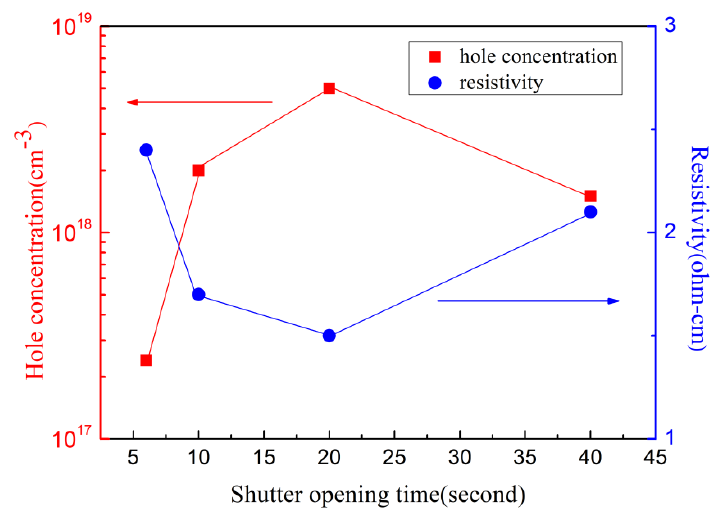
Figure 7. Comparison of hole concentration and resistivity vs metal source shutter opening time.